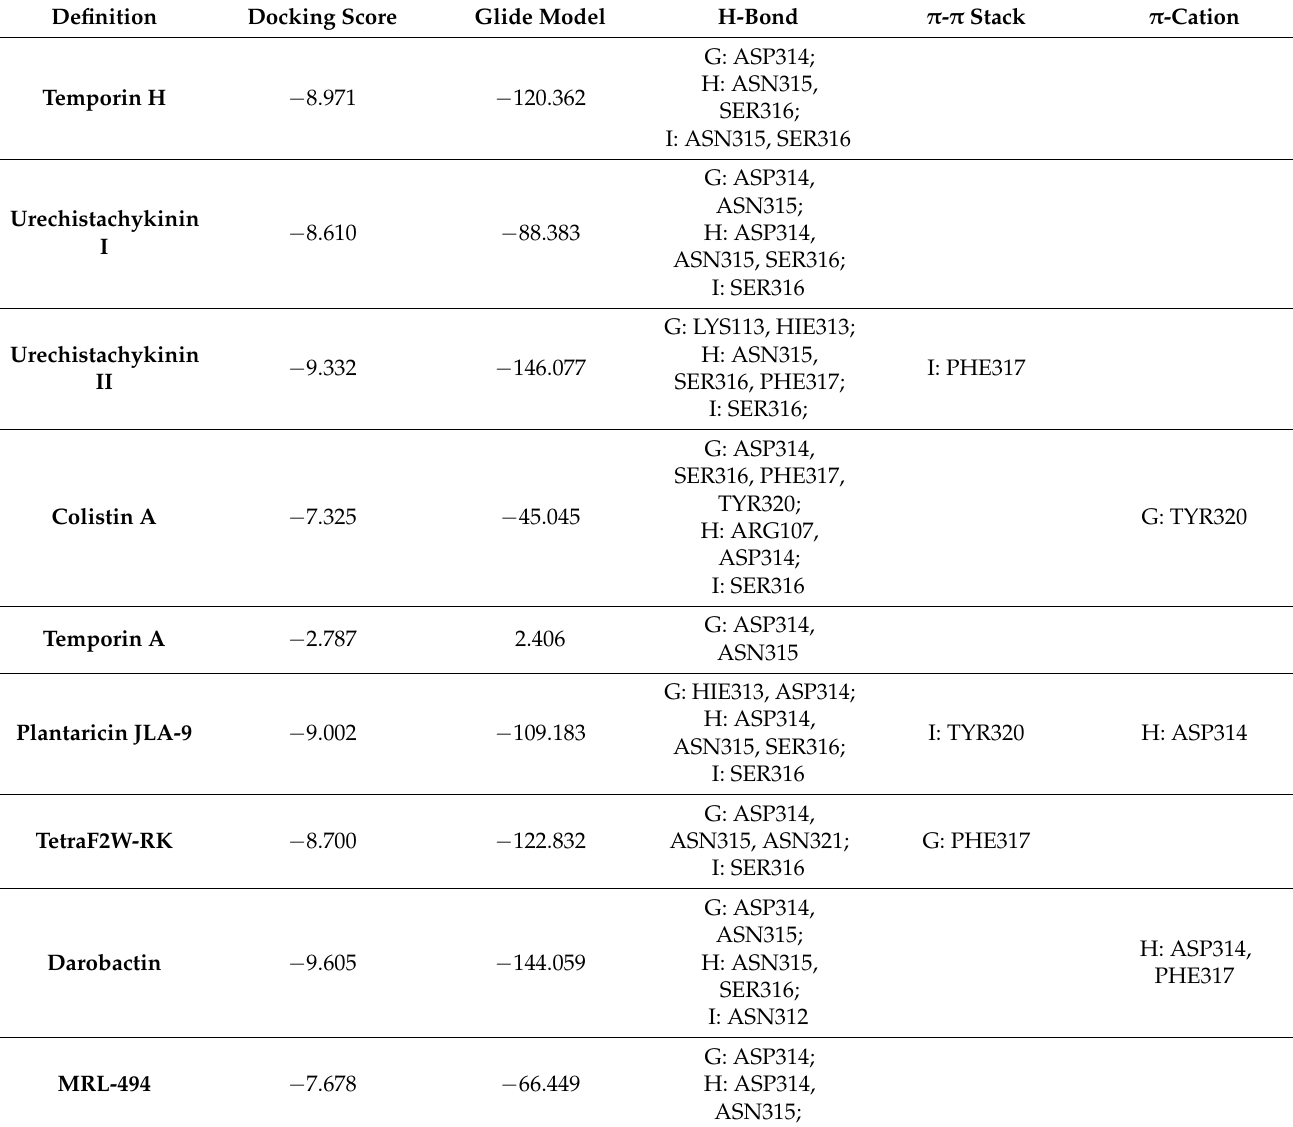
Table 3. AMPs screened by APD3 and the Standard Precision (SP)-peptide mode docking score and interactions with the receptor. The selection of residue groups located within 3 Å of the AMP ligand. Definition Docking Score Glide Model H-Bond π - π Stack π